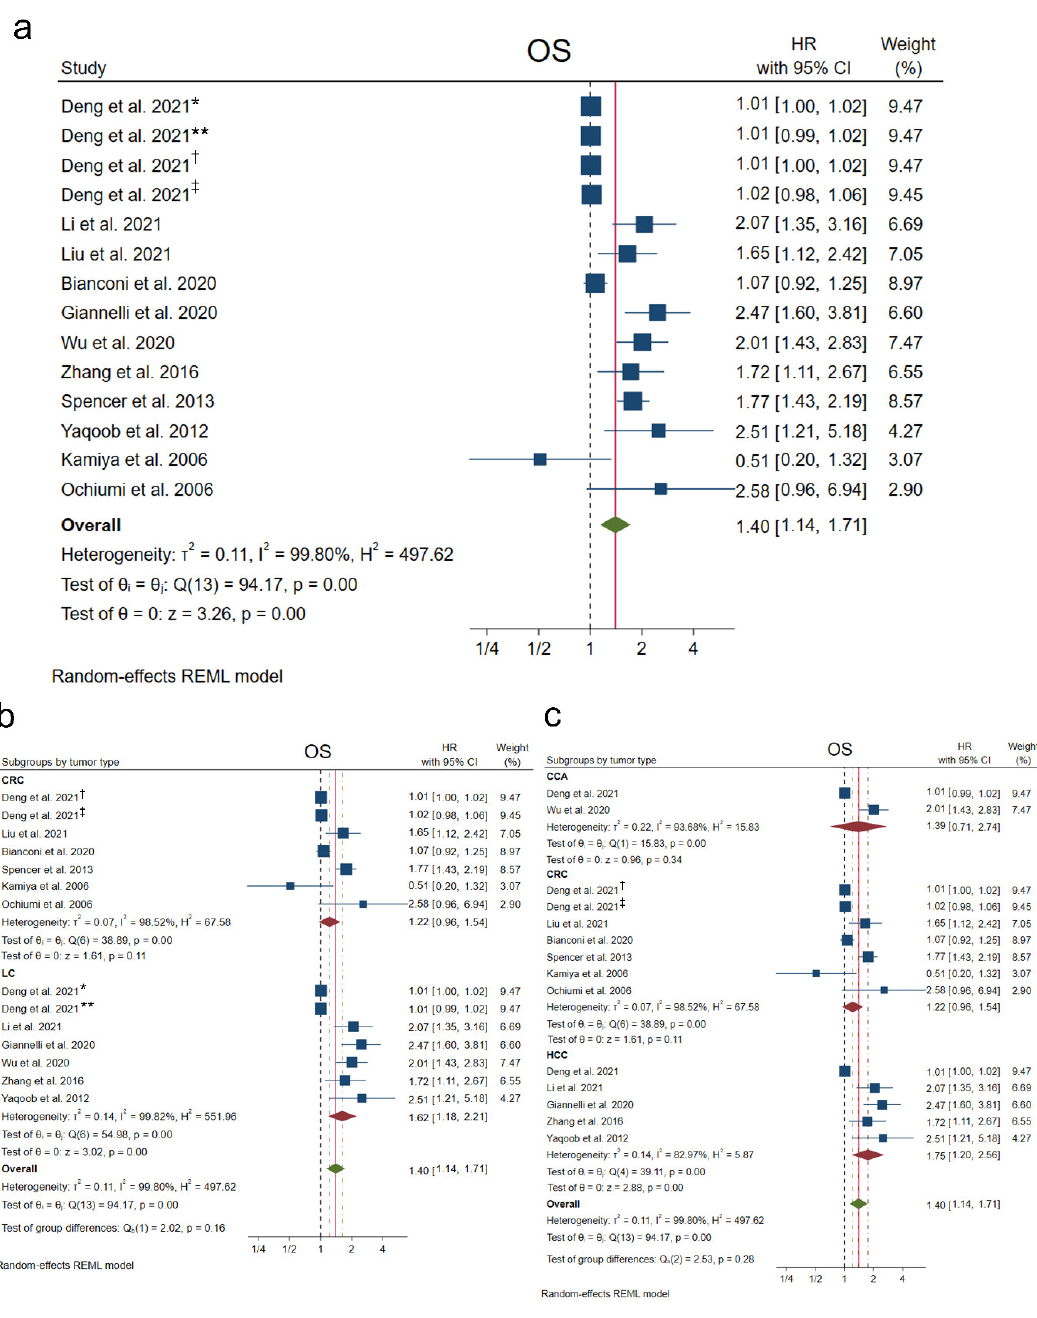
Figure 2. Forest plots showing HR for the association between NRP1 overexpression and OS among ( a ) all included studies, [21–25,28–33] ( b ) separately CRC and liver cancer studies, and ( c ) separately for CCA, CRC and HCC studies. CCA, cholangiocarcinoma; CI, confidence interval; CRC, colorectal cancer; HCC, hepatocellular carcinoma; HR, hazard ratio; LC, liver cancer; OS, overall survival; REML, Restricted Maximum Likelihood. * HCC patients, ** CCA patients, † colon adenocarcinoma patients, ‡ rectum adenocarcinoma